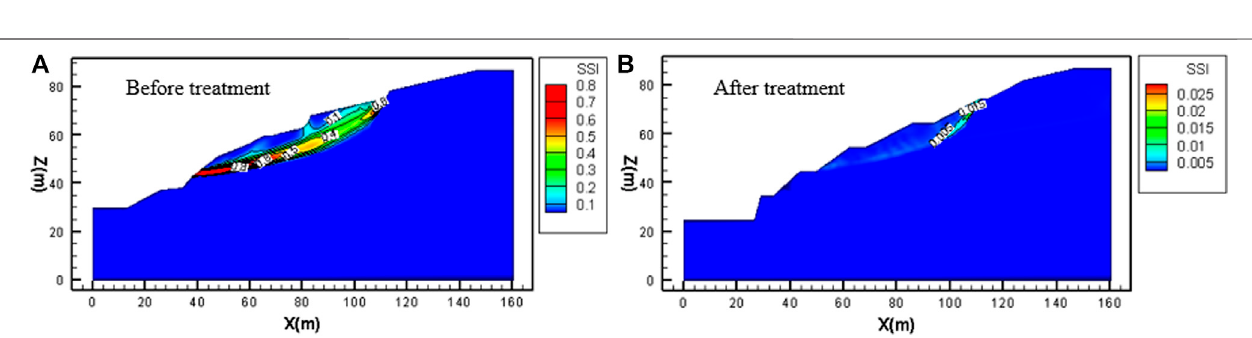
FIGURE 12 | Maximum shear strain increment nephogram before and after treatment. (A) : Before treatment, (B) : After treatment.